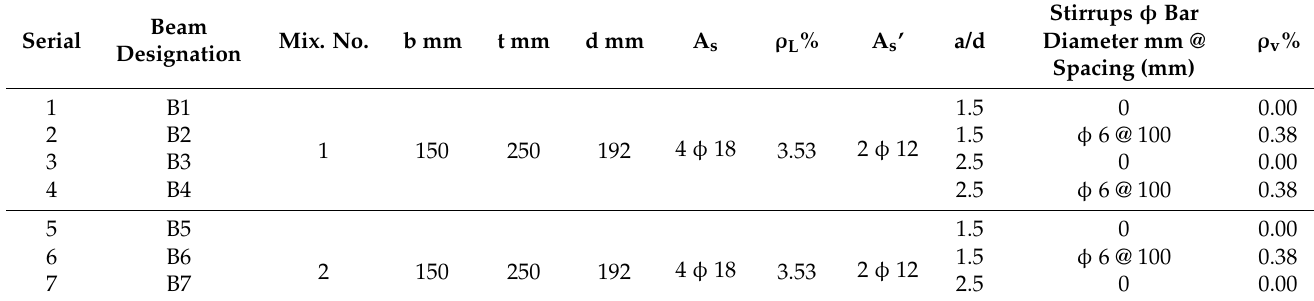
Table 4. Tested beams